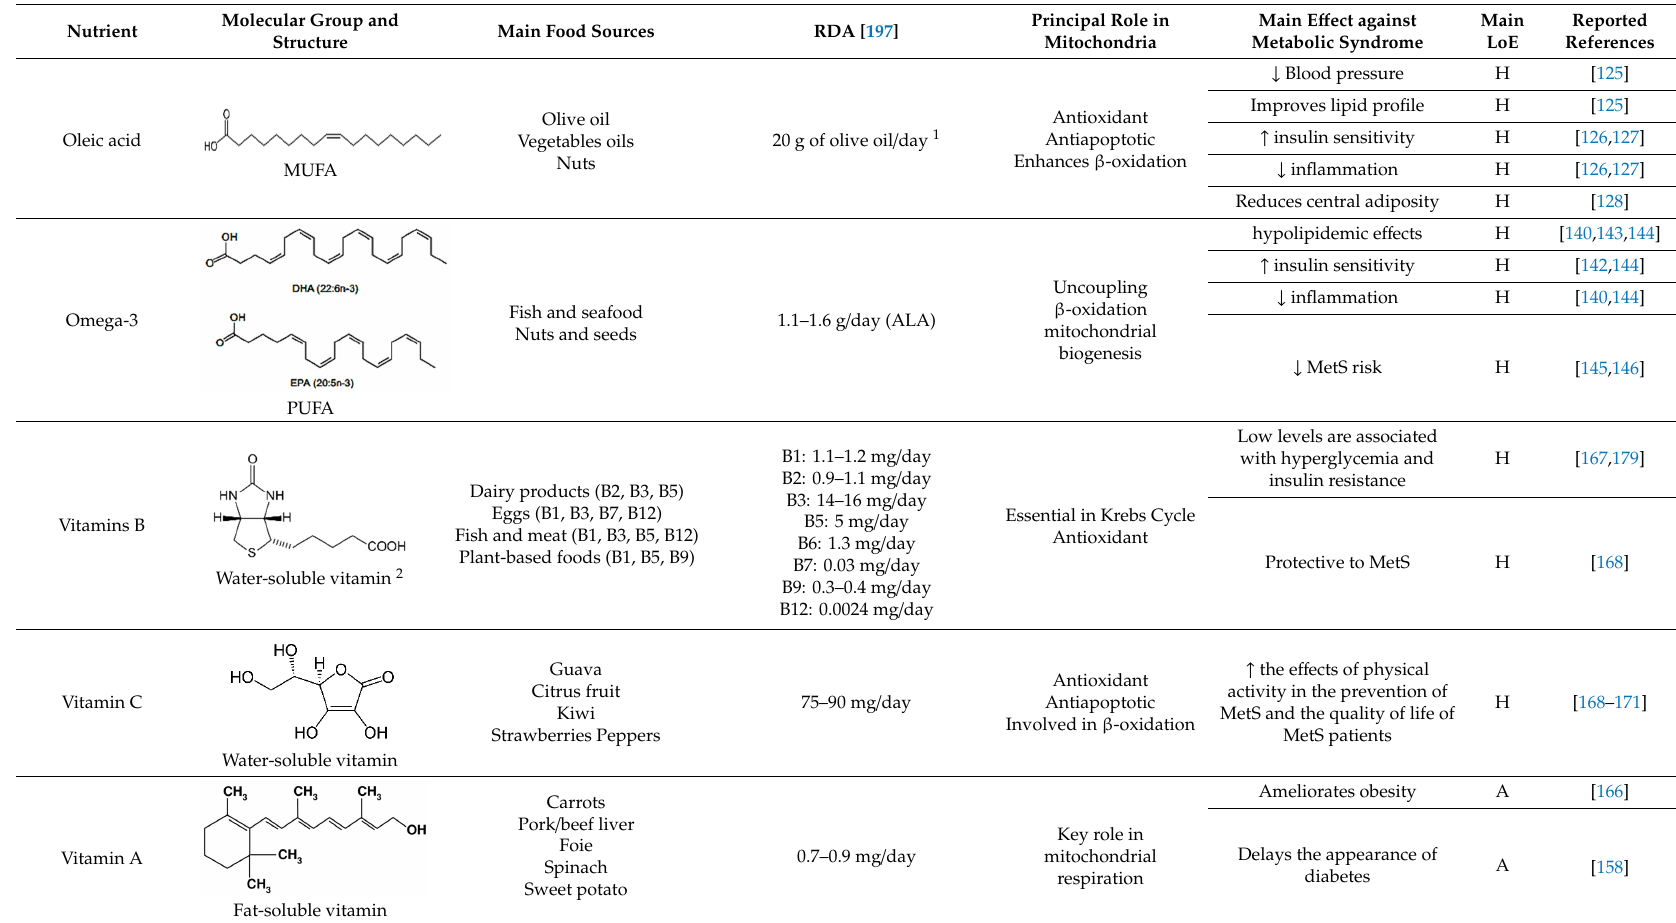
Table 2. Summary of the principal nutrients with beneficial mitochondrial effects influencing metabolic syndrome.